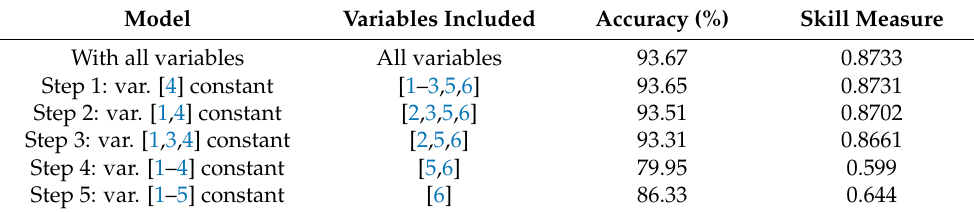
Table 4. The outcome of MLP model with backwards stepwise constant